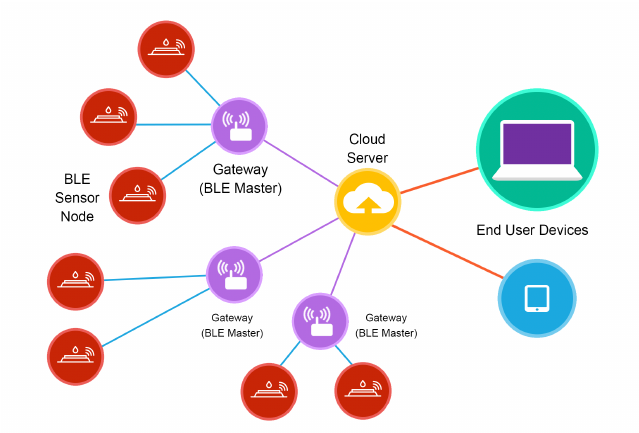
Figure 1. The proposed BLE-based wireless network topology: BLE communication between sen- sor nodes and gateways. Gateways are connected to the cloud server via Ethernet. Users can control/monitor nodes using the web application.